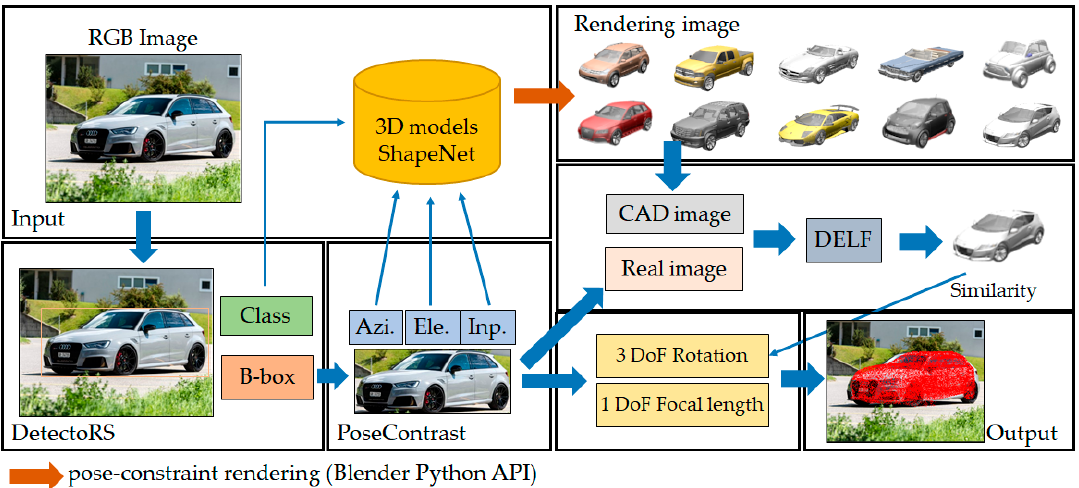
Figure 2. The proposed 4-DoF pose estimation pipeline.